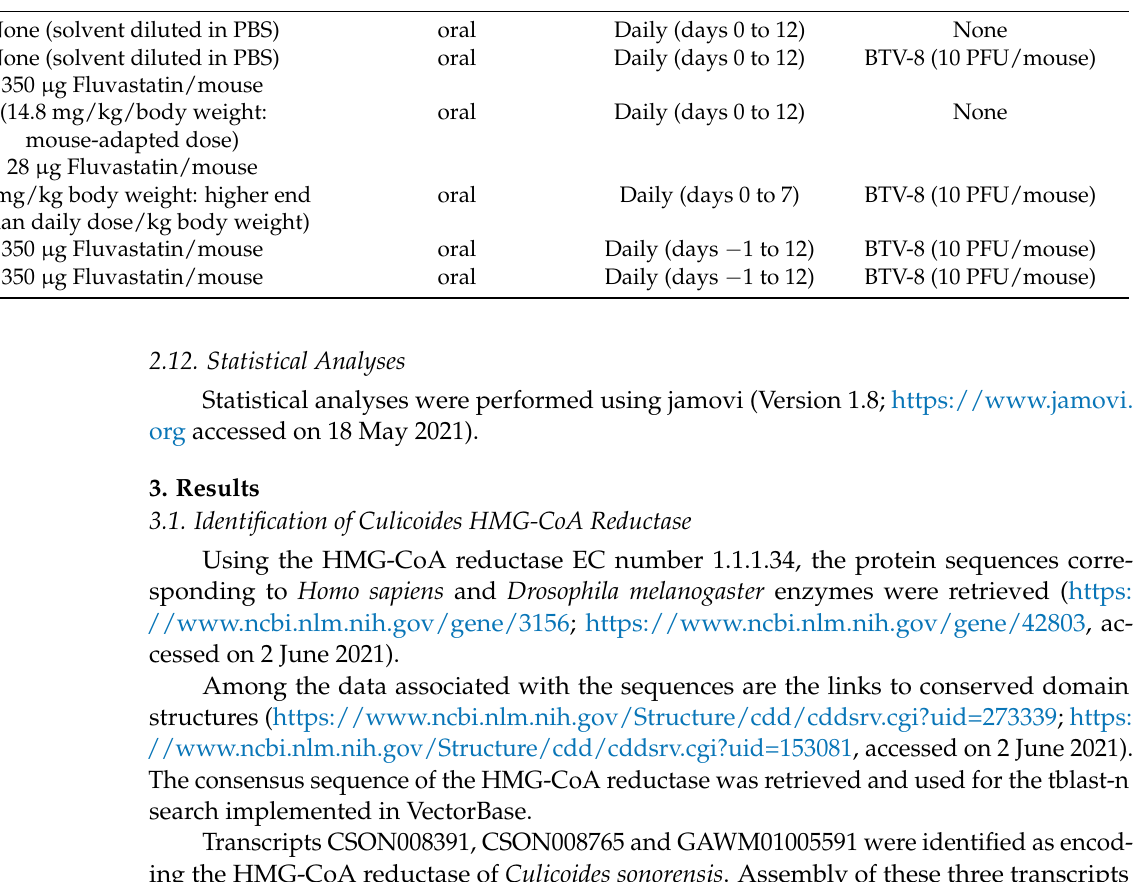
Table 1. Details of the six groups of IFNAR ( − / − ) mice used in assessing potential antiviral effect of fluvastatin against bluetongue virus (BTV). PBS: Phosphate-buffered saline; PFU: Plaque forming unit. Group Fluvastatin Dose Challenge